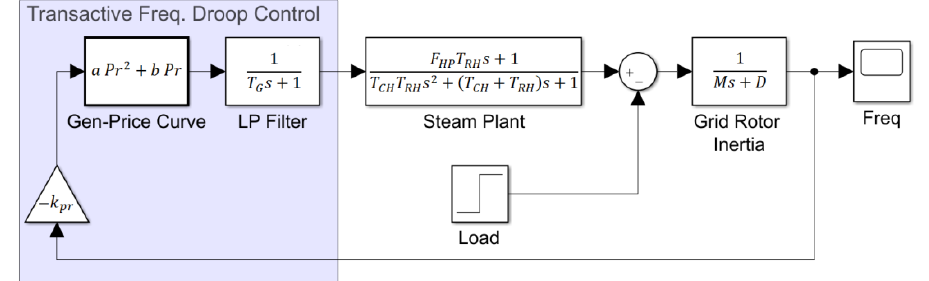
Figure 2. Steady-state power generation vs. electricity price. 2.3. Closed-Loop System Analysis To demonstrate the transactive frequency control scheme, we use the same steam plant and